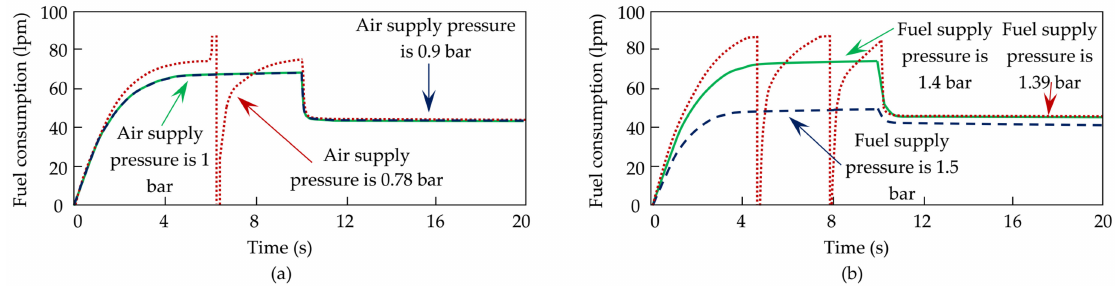
Figure 13. Fuel consumption for ( a ) di ff erent air pressures; and ( b ) fuel pressure variation at fixed air